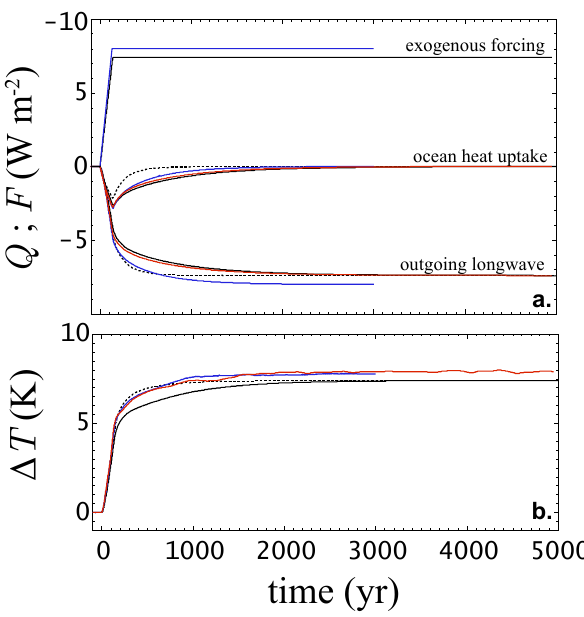
Fig. 2. (a) The exogenous forcings, ocean heat uptake and out- going long wave radiative heat fluxes associated with the tempera- ture perturbations shown in (b) (see text). The exogenous forcings marked black are common to both the GEBM and AOGCM model runs. (b) The global surface temperature response of three climate models to the exogenous forcings shown in (a) : MAGICC-GEBM with (black) and without (black-dashed) polar sinking; UVicESCM- EMIC (blue); GFDLR15a-AOGCM (red).